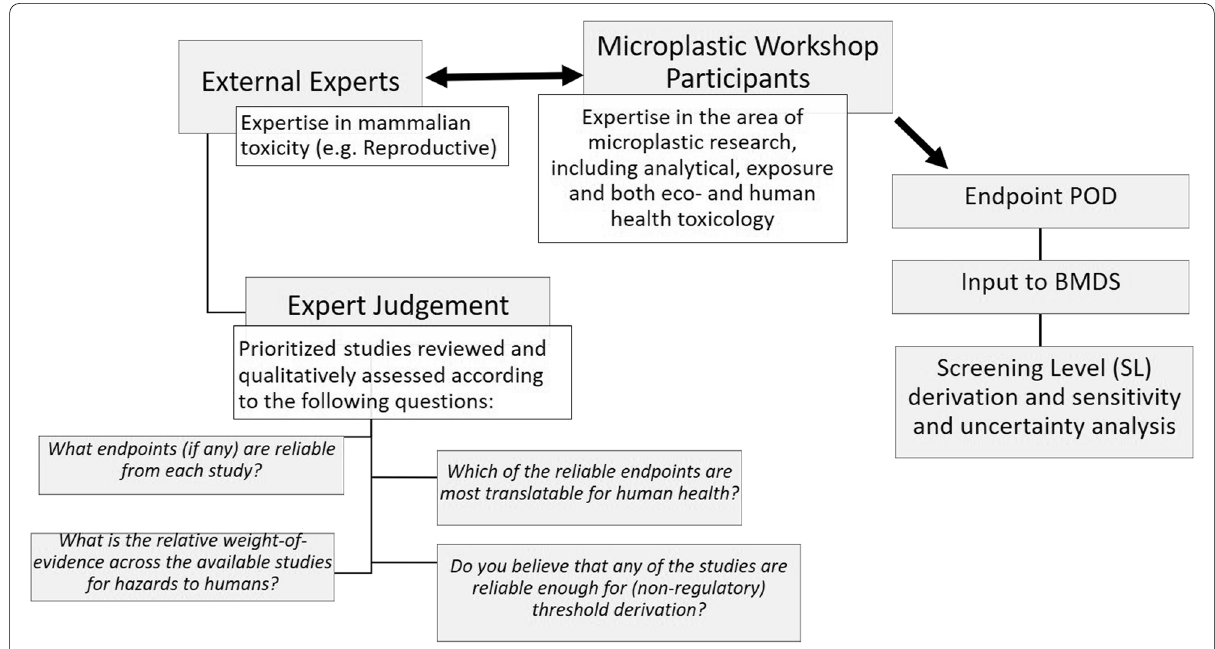
Fig. 1 Summary of workshop process adopted towards derivation of a non-regulatory human-health screening level value for monitoring microplastics in California drinking water. BMD benchmark =